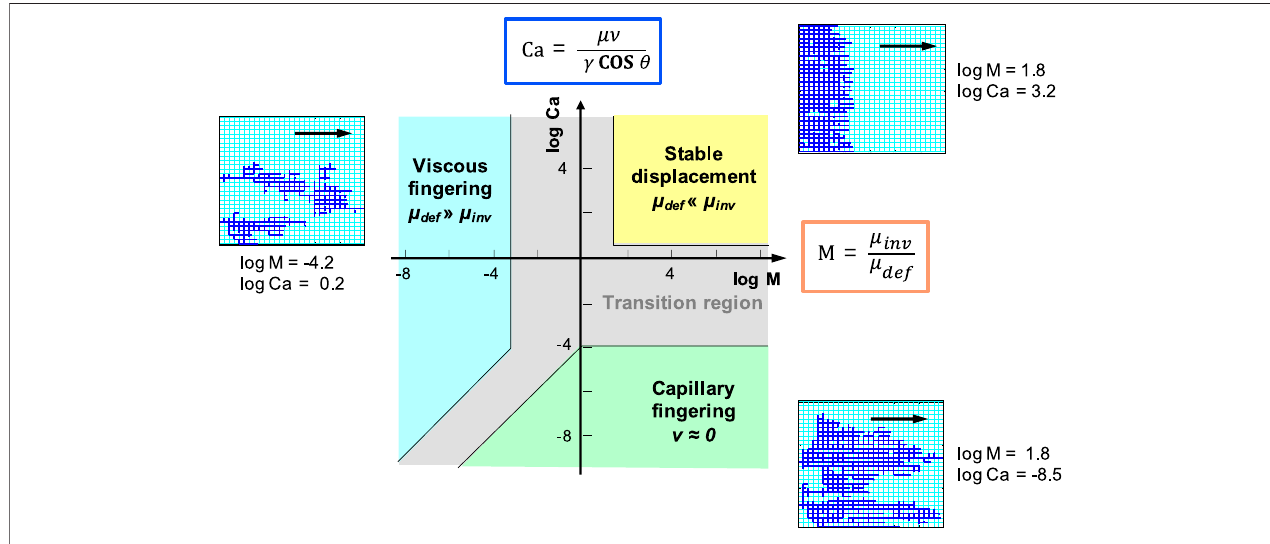
FIGURE7| Mixed fl uidinstabilitiesatconstantfabric.Regimesforviscous fi ngering,capillary fi ngering,andstabledisplacementinthespacede fi nedbythecapillary number Ca and viscous ratio M (Schematic representation — after Lenormand et al., 1988. Pore network simulations are conducted by Sheng Dai.).